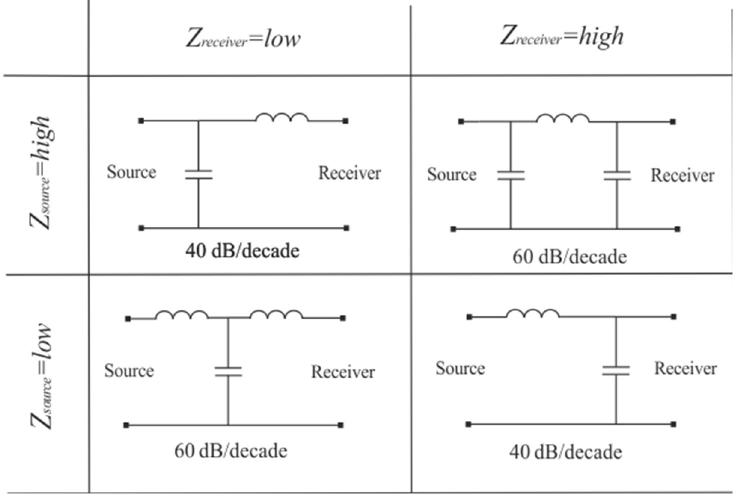
Figure 1. Criterion for the choice of filter topology based on impedance mismatching.